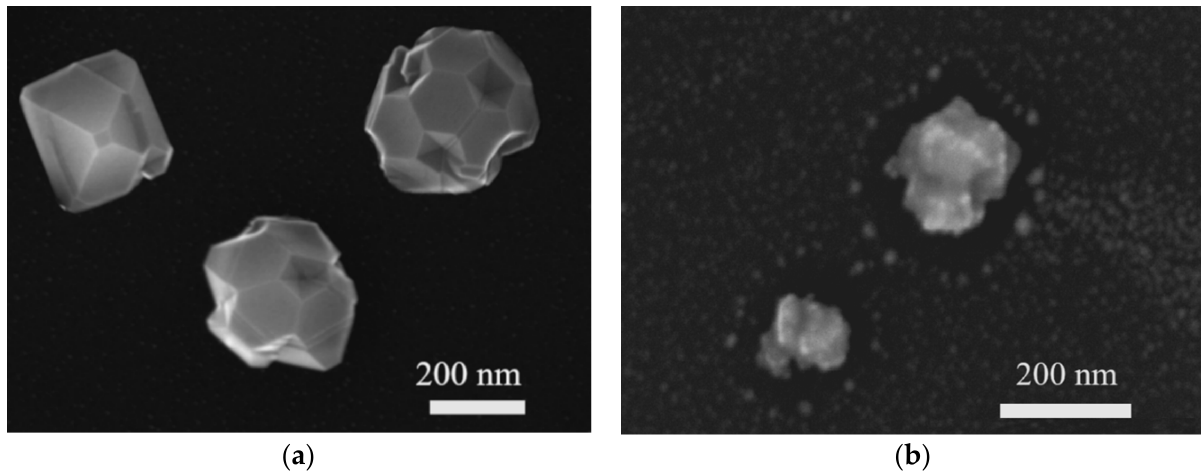
Figure 1. SEM images of as-grown nanodiamonds ( a ) and etched nanodiamonds ( b ). SEM Merlin (Zeiss), accelerating voltage—10 kV with a probe current of 150 pA. The scale bars are shown.